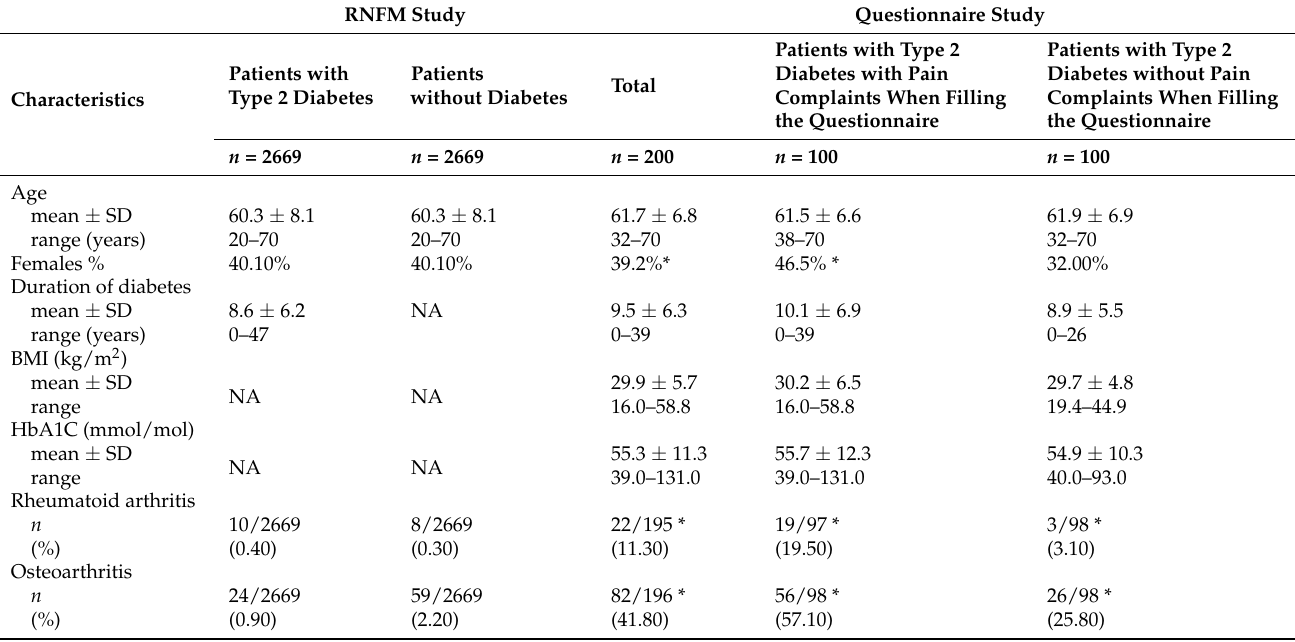
Table 1. Study population demographic data of the two different approaches in Dutch general practice: (RNFM approach n = 5338, Questionnaire approach n = 200).